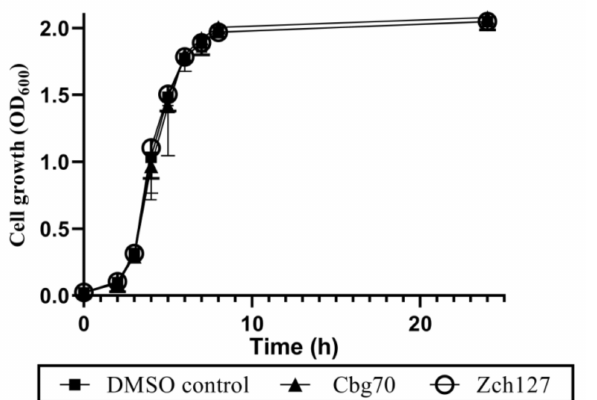
Figure 2. Effect of Enterobacter sp. culture supernatant extracts on bacterial growth of P. mirabilis . Growth of Proteus mirabilis isolates under the effect of sub-minimum inhibitory concentrations (sub-MIC) (0.5X MIC) concentrations of Cbg70 (0.08 mg/mL) and Zch127 (0.6 mg/mL) extracts at different time points measured as turbidity (OD 600 nm) while shaking at 250 rpm. Bacterial culture supplemented with DMSO in the same concentration as extract served as DMSO control. Each experiment was performed using three different cultures for each isolate, and the average data of the ten isolates is shown.